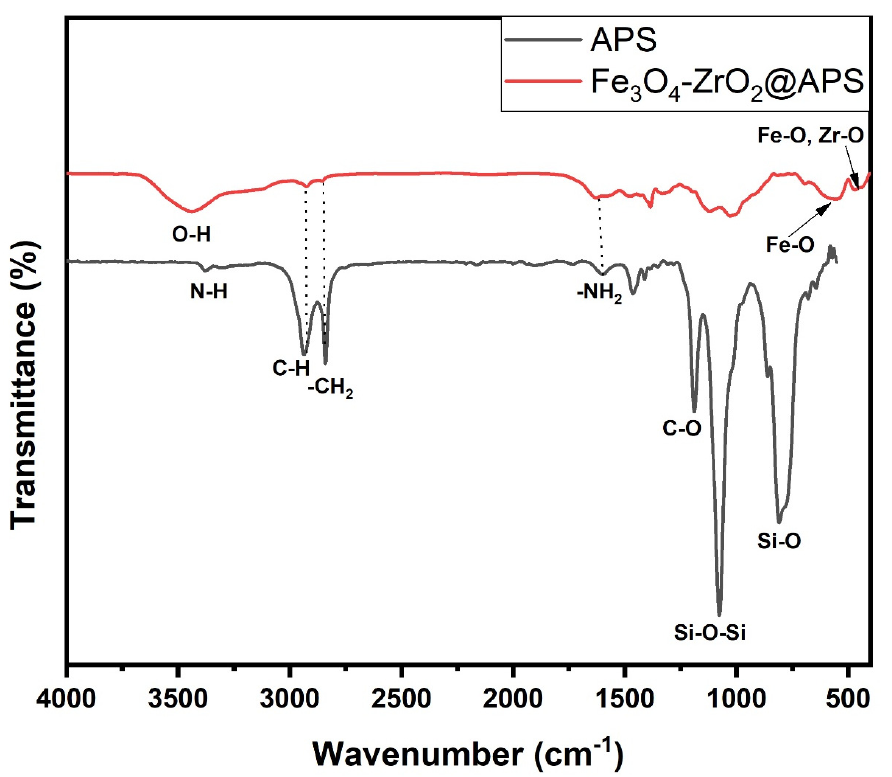
Figure 2. FTIR spectrum of Fe 3 O 4 -ZrO 2 functionalized with 3-aminopropyltriethoxysilane (Fe 3 O 4 -ZrO 2 @APS). The SEM images of Fe 3 O 4 and Fe 3 O 4 -ZrO 2 (Figure 3) were used to examine the surface morphology of the nanomaterials. The Fe 3 O 4 nanoparticles displayed rhombohedral shapes, whilst Fe 3 O 4 -ZrO 2 nanocomposite displayed mostly rhombohedral shapes with some spherical shapes. The Fe 3 O 4 -ZrO 2 @APS composite displayed a combination of rhom-